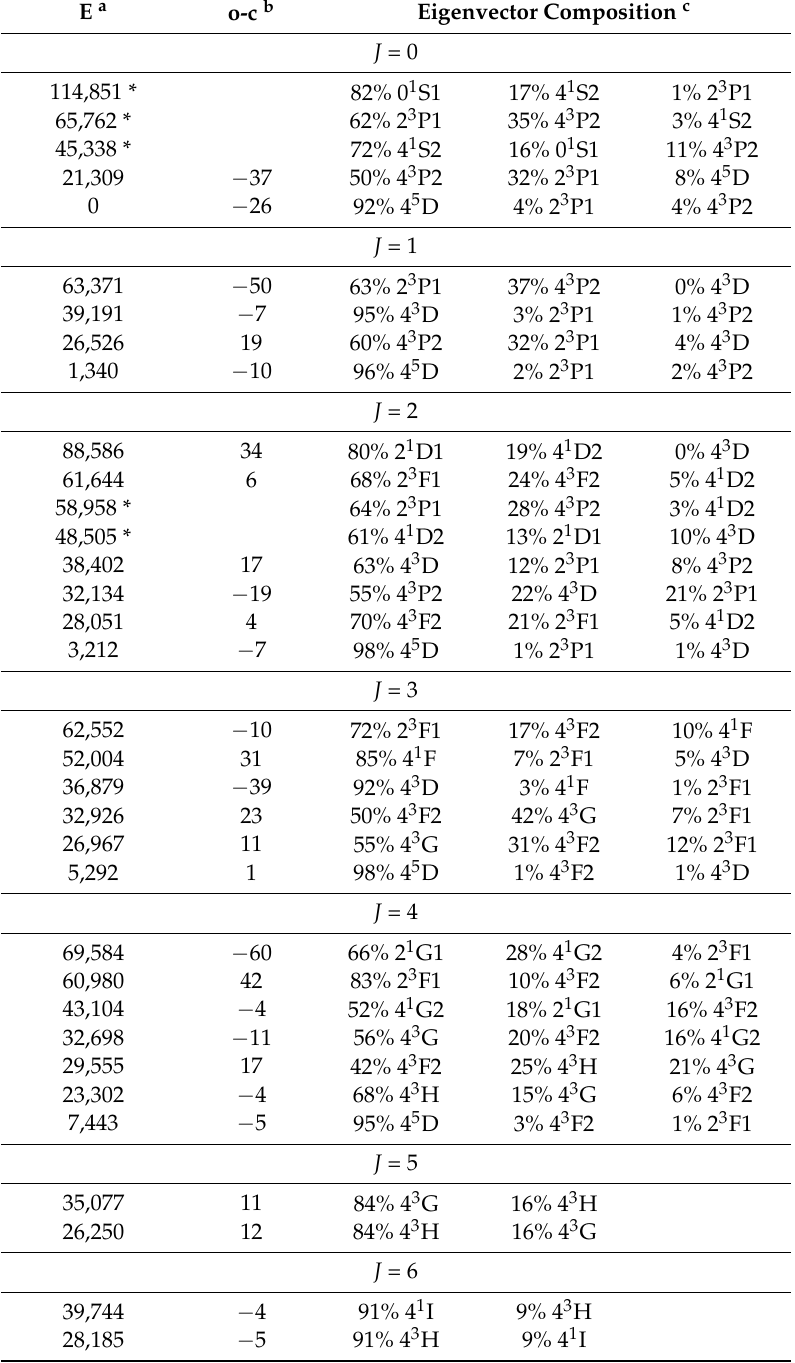
Table A7. Energies (in cm − 1 ) of the 4d 4 configuration of Ag